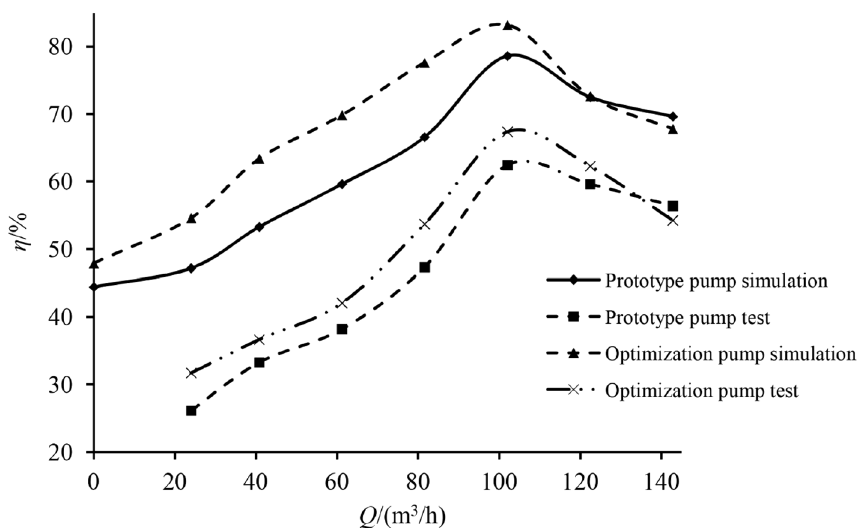
Figure 8. Efficiency curve.